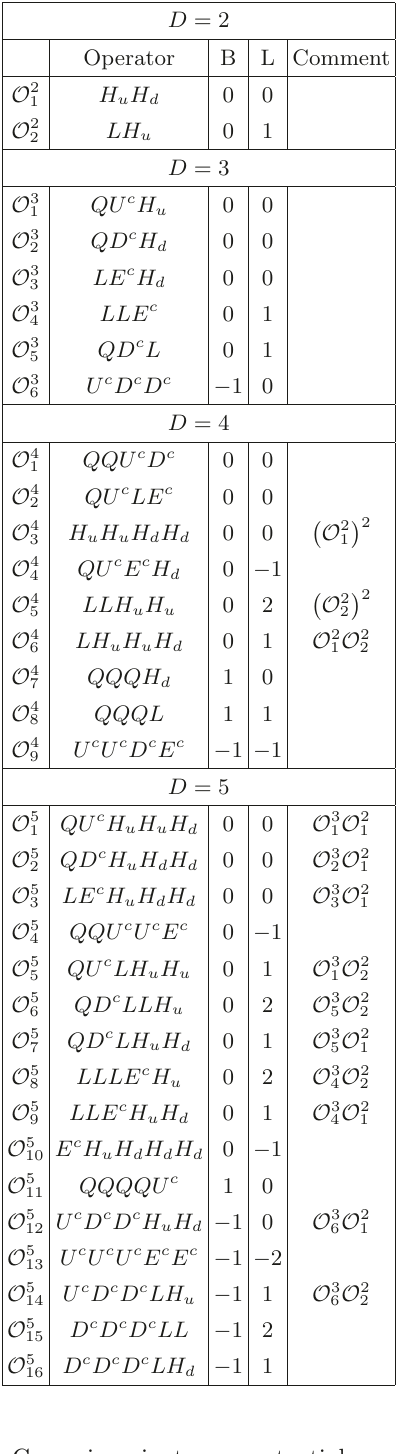
Table 9 . Gauge invariant superpotential operators of mass dimensions 2, 3, 4, 5 and 6 in the MSSM. The Baryon and Lepton numbers of the operators are also shown. In the “Comment” column we show whether an operator structure is made out of product of two lower dimensional